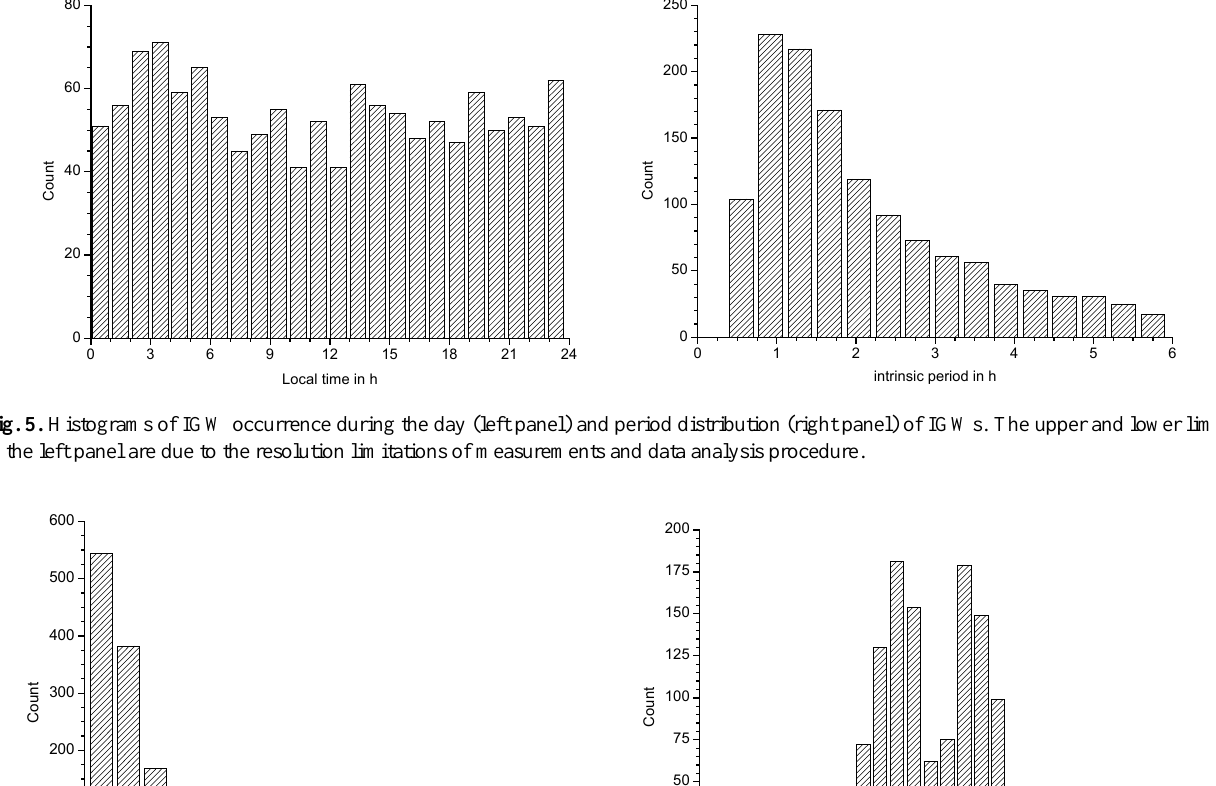
with c is the horizontal phase speed, N is the Brunt-V¨ais¨al¨a frequency, and H is the scale height. Taking H =6000 m and N 2 =5.5 · 10 − 4 s − 2 gives an upper limit of 280 ms − 1 for the phase